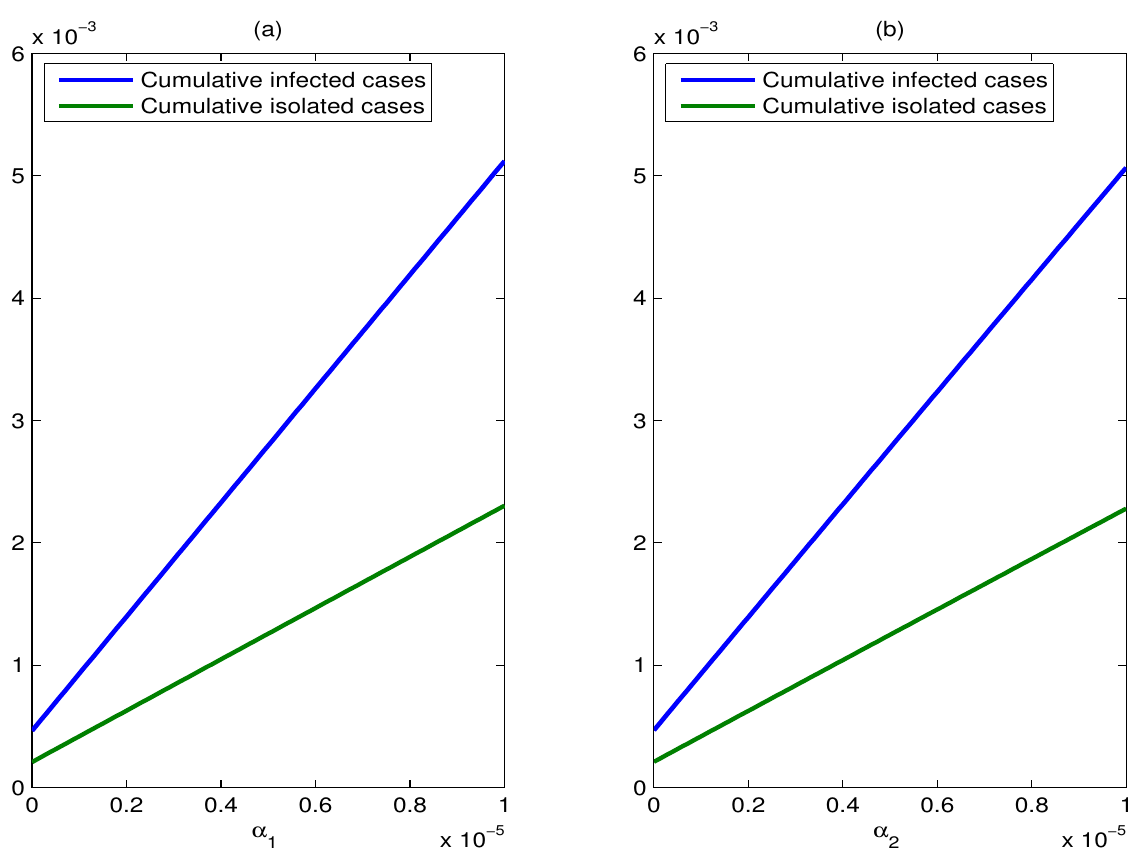
Figure 10. The effect of the imported rates of exposed individuals and asymptomatic